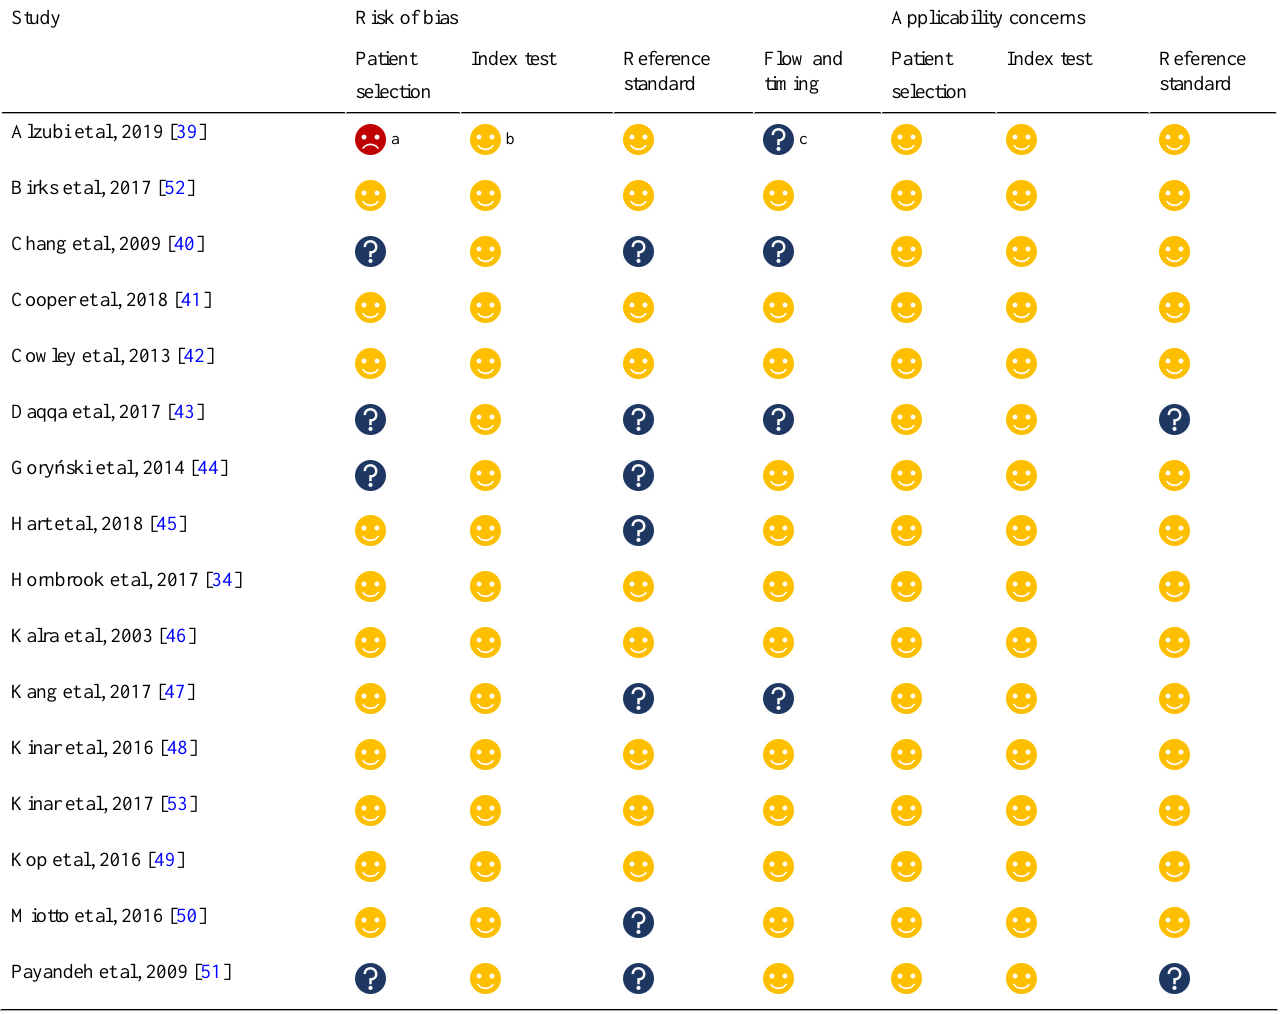
Table 5. Critical appraisal results using the Quality Assessment of Diagnostic Accuracy Studies-2